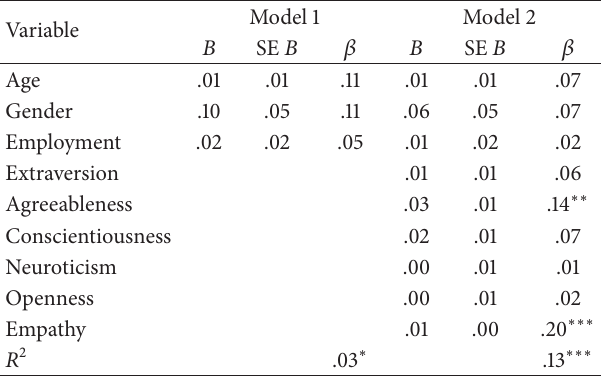
Table 4: Hierarchical multiple regression: association between demographics, personality traits, empathy, and willingness to pro- vide emotional care.